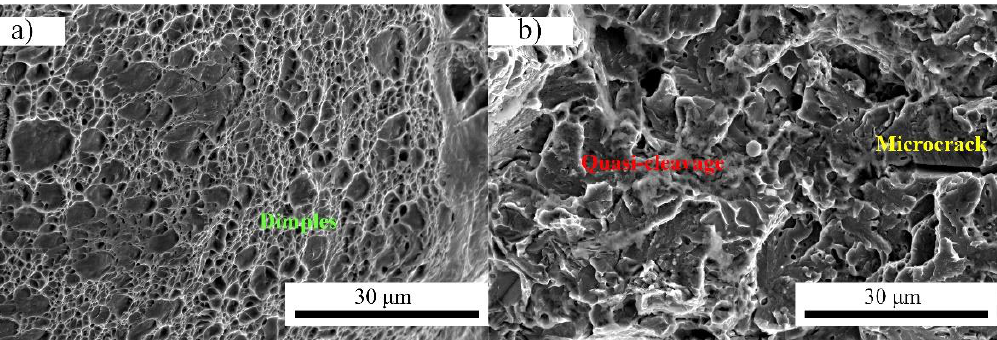
Figure 13. Slow-strain rate tensile fracture of samples E with and without hydrogen charging. ( a ) not hydrogenated; ( b ) hydrogenated.